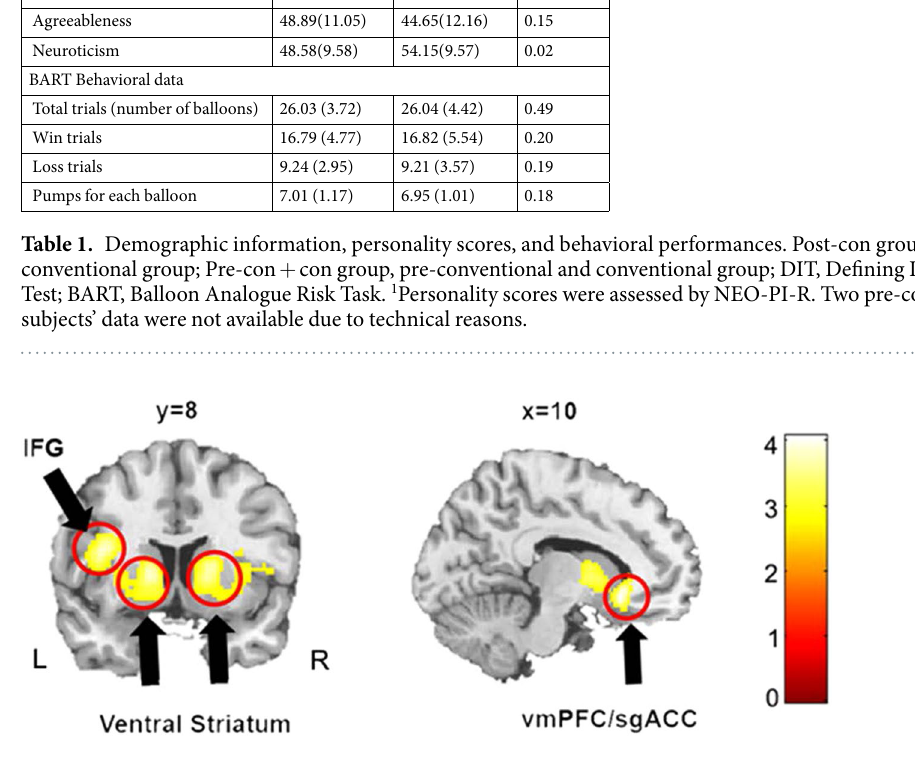
Figure 1. Differences in resting CBF between the post-con group and the pre-con + con group at whole brain level. The post-con group showed higher CBF values in the bilateral ventral striatum (VS), the ventromedial prefrontal cortex/subgenual anterior cingulate cortex (vmPFC/sgACC), and the inferior frontal gyrus (IFG/AIS) compared to the pre-con + con group. All regions survived whole brain cluster-level FWEcorrection at p <